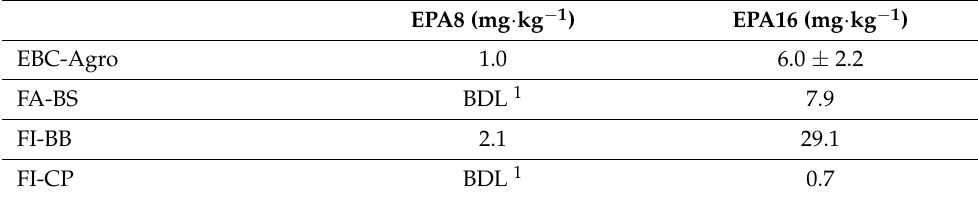
Table 3. PAH concentrations of the produced biochars from farm-scale equipment together with the EBC-Agro limit values.